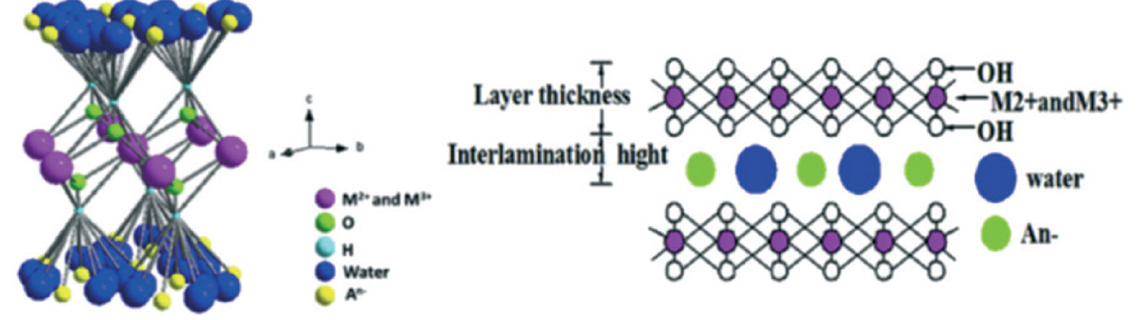
Figure 18. Schematic of the LDH structure. Reprinted with permission from Ref. [244]. Copyright 2015 Elsevier.